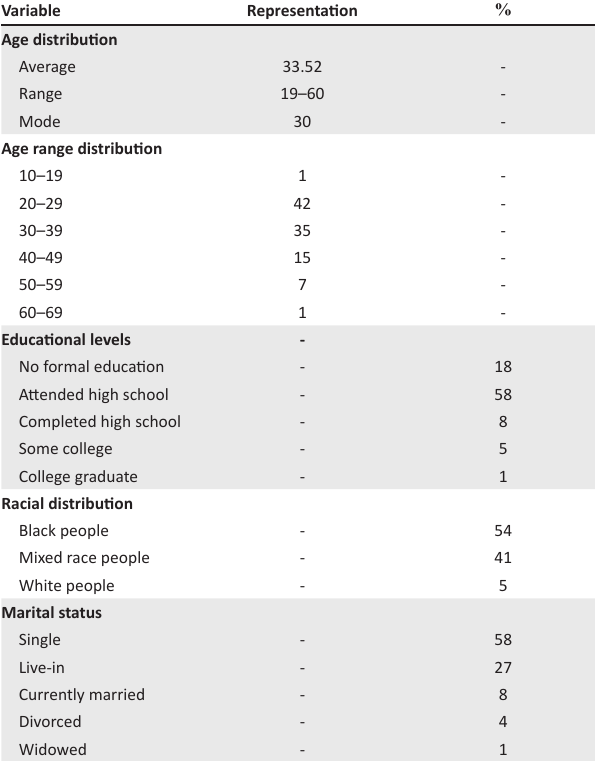
FIGURE 2: Responses of study participants on condom breakage and slippage.